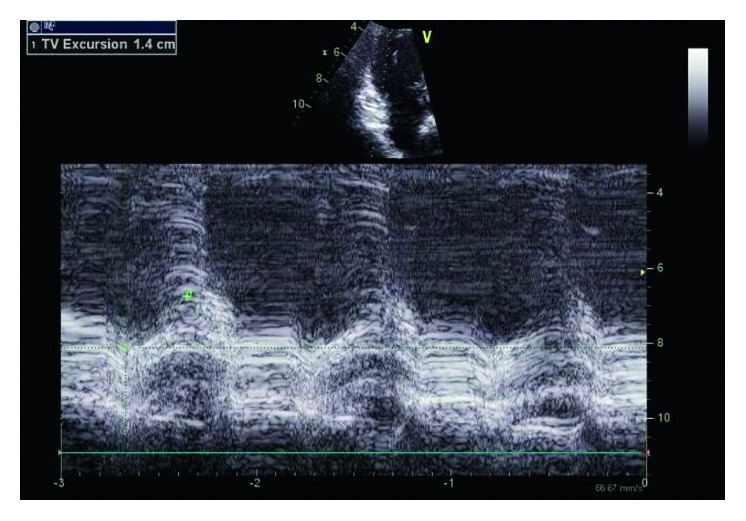
TAPSE of 1.4 cm.